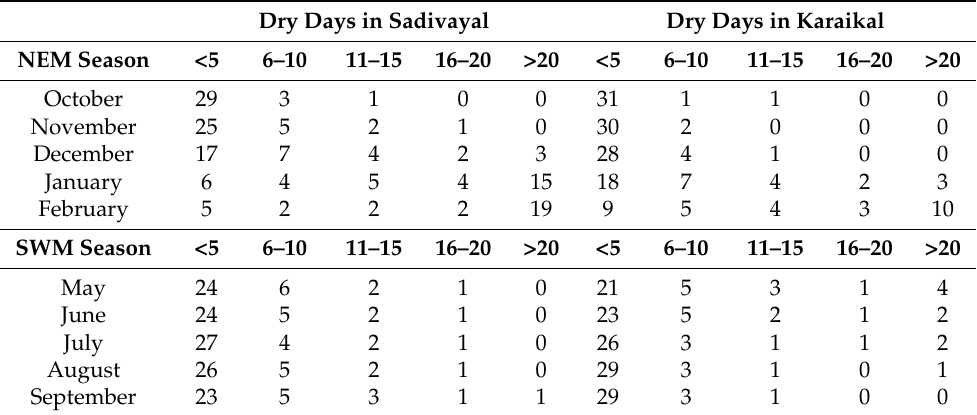
Table 5. Prolonged dry-spell category analysis during major rice-growing seasons in Sadivayal and